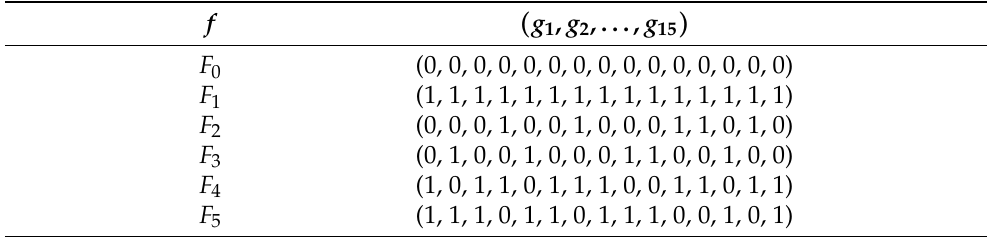
Table 1. The six circuits that are nearest to majority function using the search scheme in Figure 2. For the gates g 1 , . . . , g 15 , 0 stands for NAND and 1 stands for